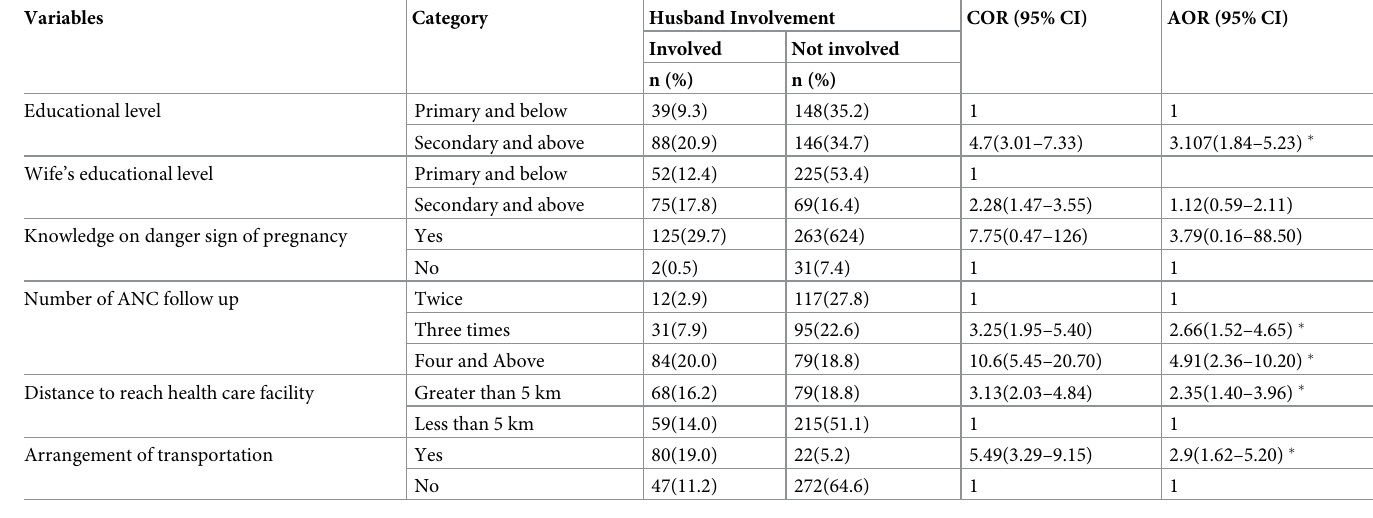
Table 5. Factors associated with Husband involvement in Birth preparedness and complication readiness in Kucha district, Gamo zone, Southern Ethiopia,